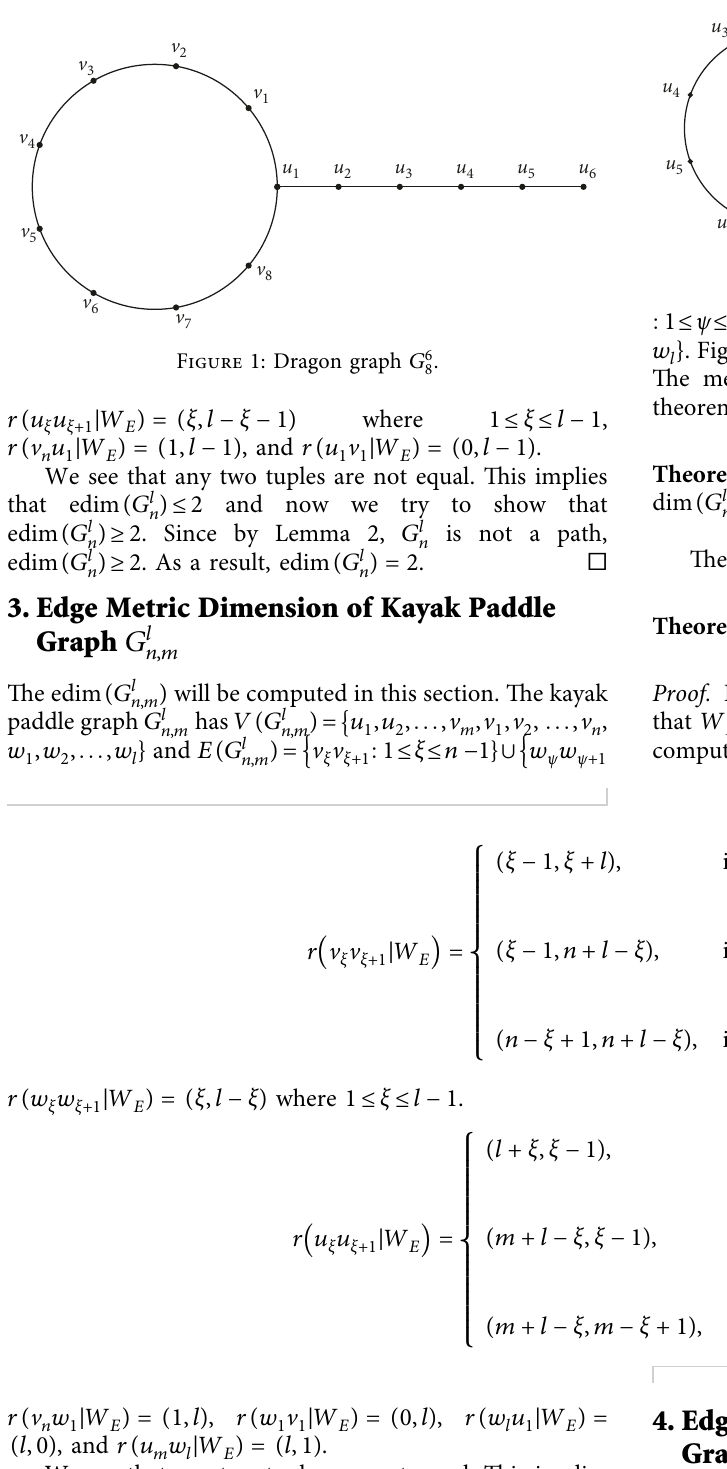
Figure 2: Kayak paddle graph G 4